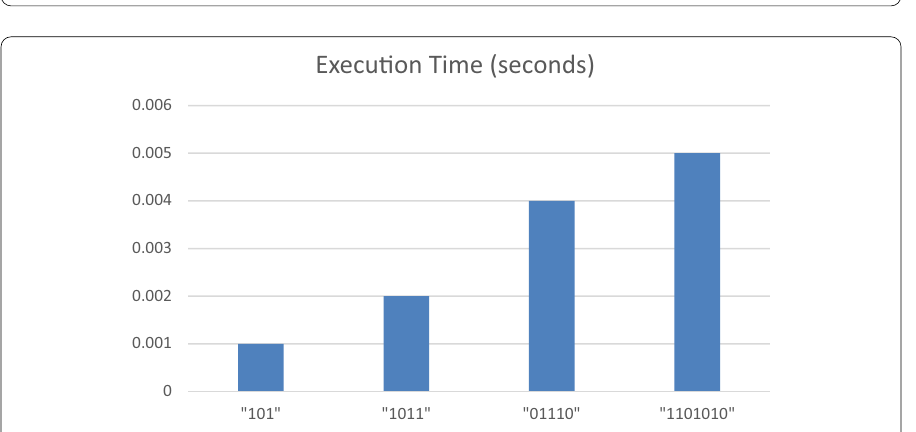
Fig. 25 Execution times of classical bit strings—left or clockwise rotation